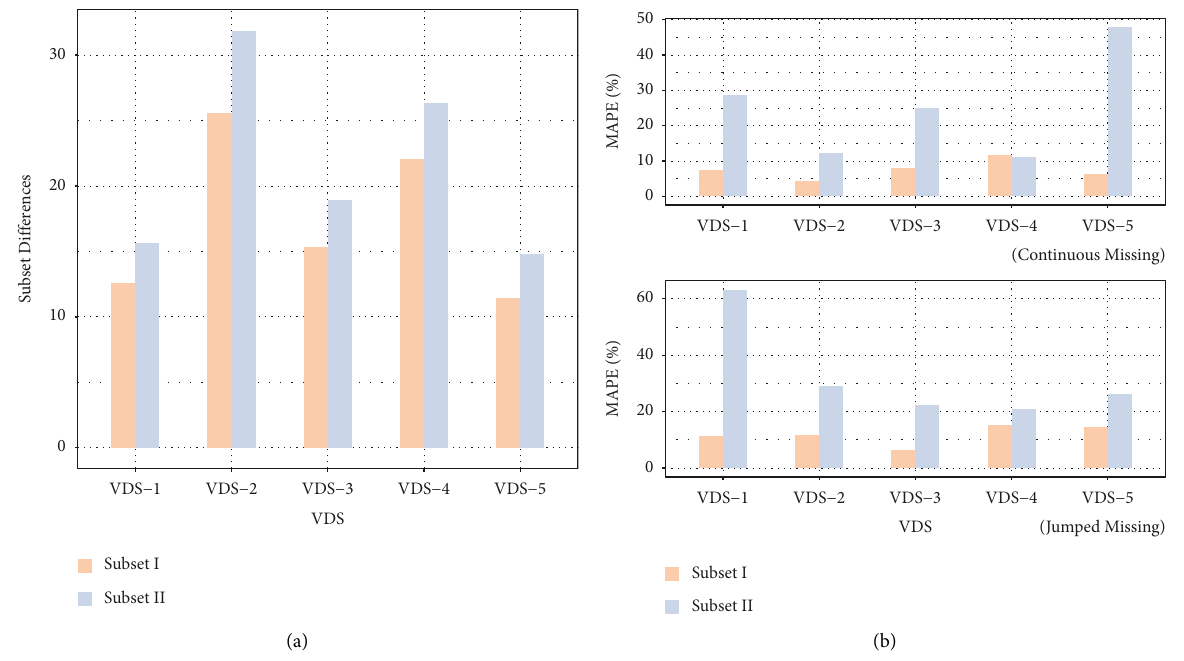
Figure 8: Comparison of the subsets’ differences of the VDS. (a) Subset differences’ comparison and (b) imputation performance comparison. Table 7: Comparison of imputation results of different models on continuous missing (MAPE). Imputation